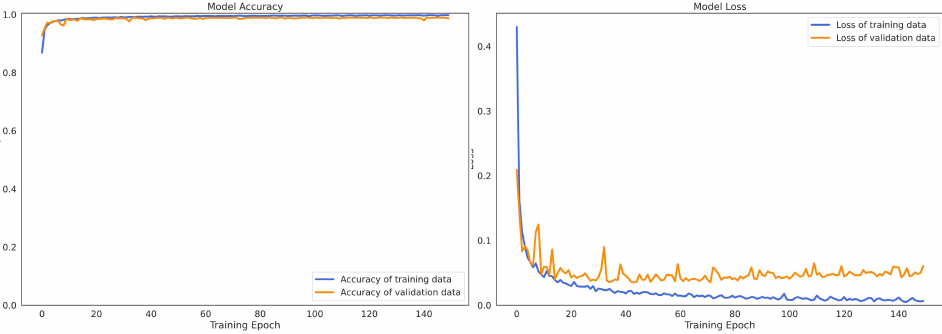
Figure 10. The change of model accuracy and loss in the training and validation data of the SEResNet- BiGRU on MobiAct v2.0